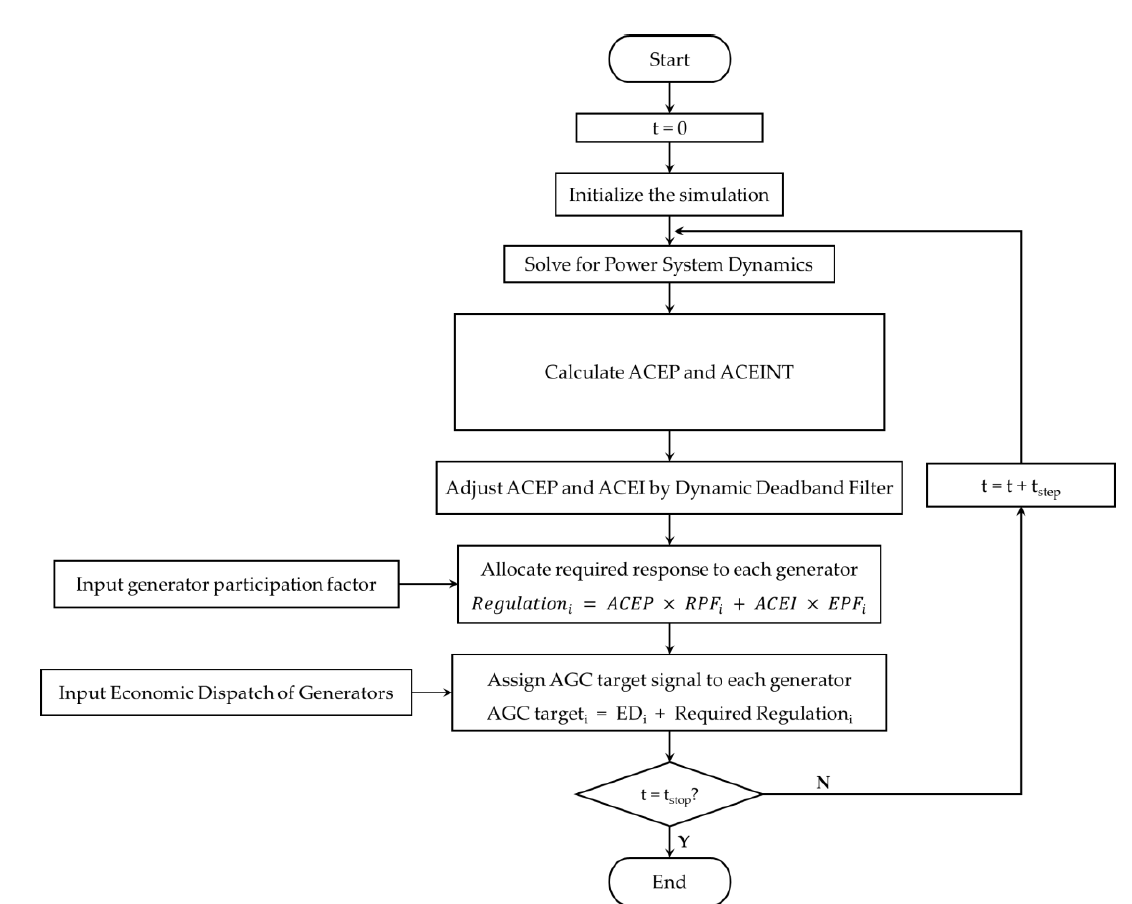
Figure 5. Simulation process of the AGC frequency control.